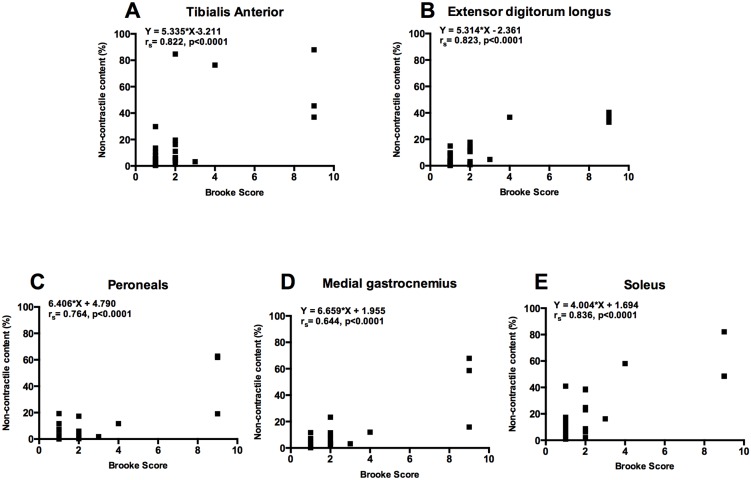
Relationship between NCC of different leg muscles and Brooke score.There was a significant relationship between NCC of all leg muscles and Brooke score (rs; 0.64–0.84, p<0.0001).